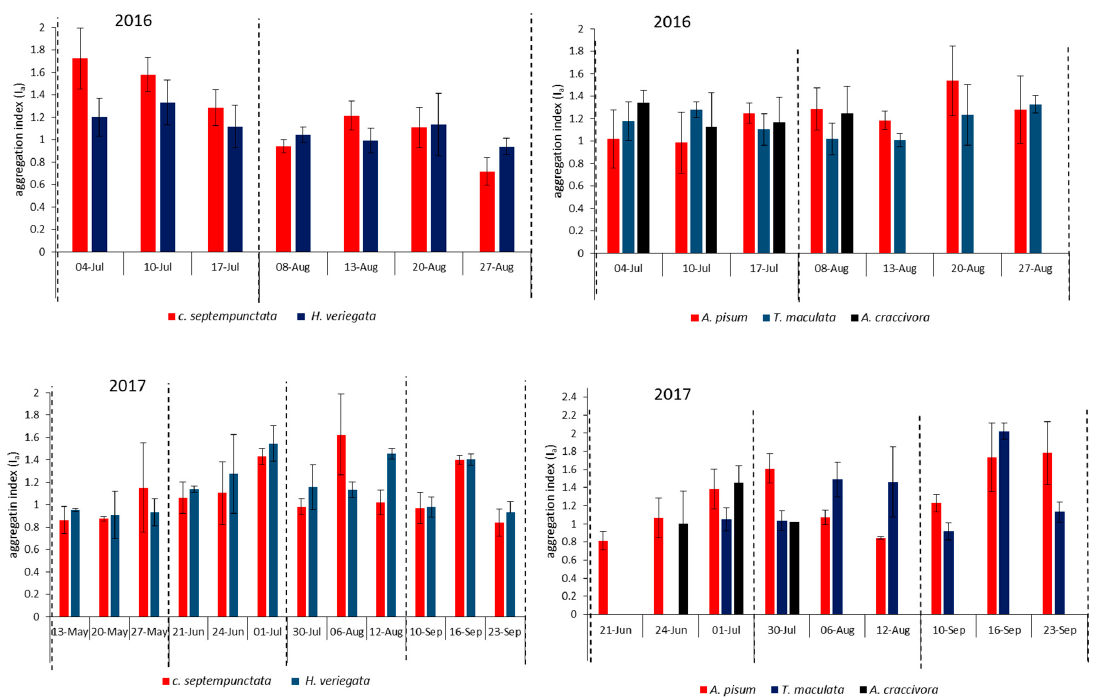
Figure 3. The average of the index of aggregation ( I a ) of coccinellids (left) and aphids (right) in 2016 and 2017 (dashed lines indicate alfalfa harvest times). Bars indicate standard errors.